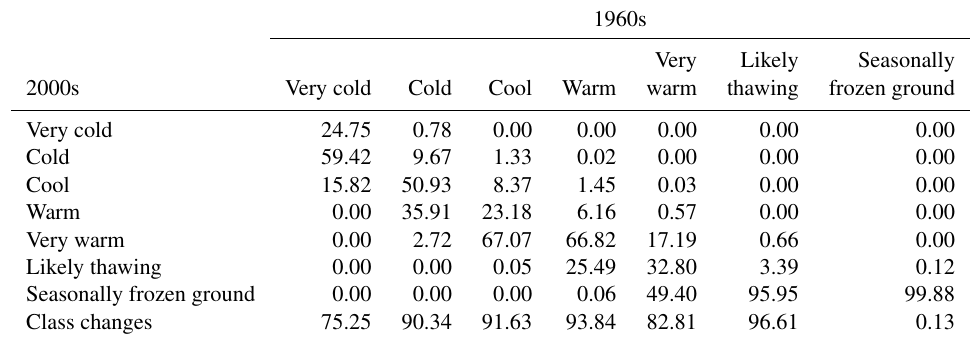
Table 4. Transfer matrix of permafrost types from the 1960s to the 2000s in the QTP (%).